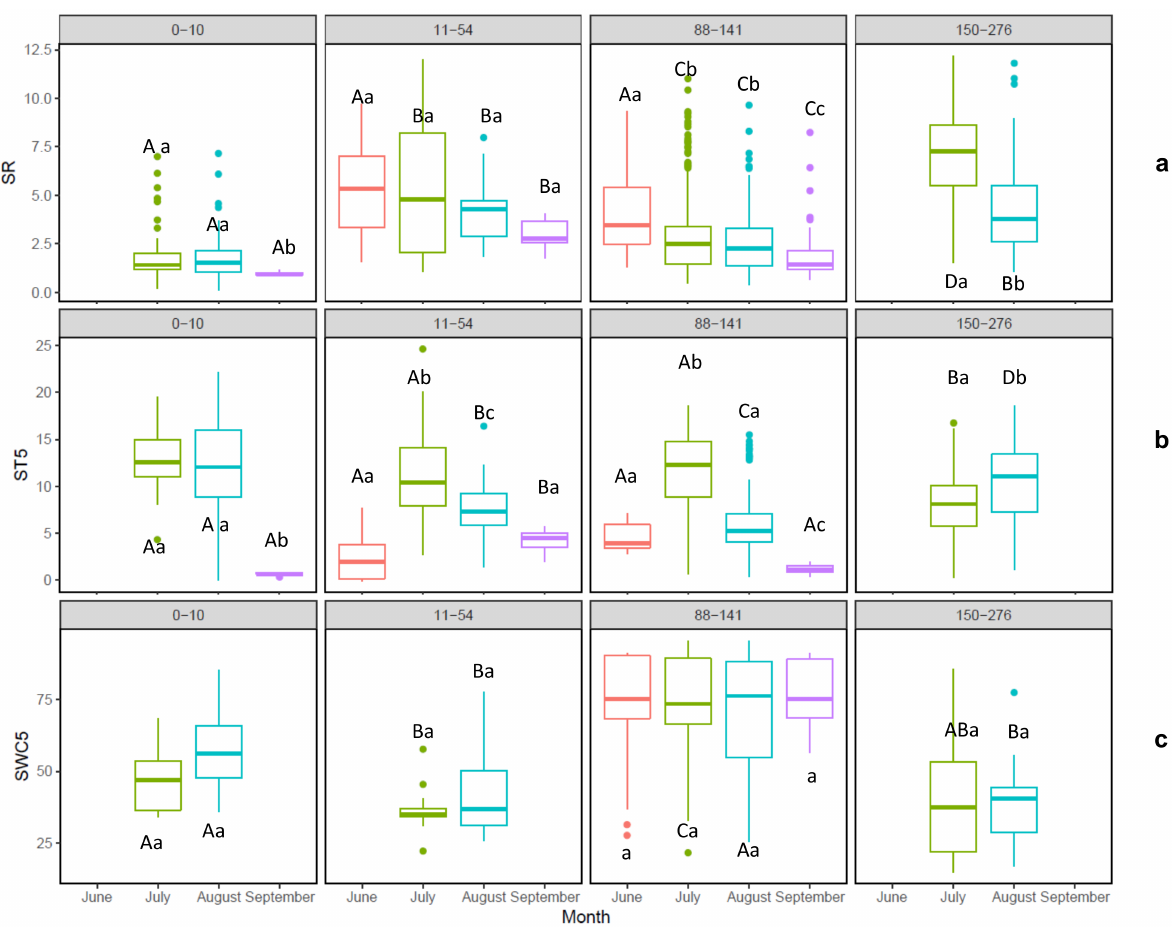
Figure 4. ( a ) Soil respiration (SR, µ mol CO 2 m − 2 s − 1 ); ( b ) soil temperature (ST5, ◦ C); ( c ) soil water content (SWC5, %) in wildfire-affected stands of different ages during the growing season. The horizontal line within the box indicates the median, box boundaries indicate 25th and 75th percentiles, whiskers indicate highest and lowest values, and dots above or below the whiskers indicate the outliers. Medians followed by different letters in the same plot are significantly different at p < 0.05 according to the Kruskal–Wallis test extended with the Wilcoxon test. Lowercase letters indicate significant differences between the SR values of same age group during the growing season (between different months within one panel, e.g., within 0-10). Uppercase letters indicate significant differences in the SR of different age groups within the same month (e.g., June). The figure in the grey bar at the top side indicates the age interval of larch